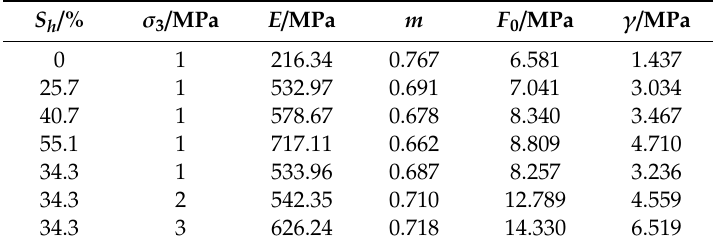
Table 1. The residual strength correction coe ffi cient δ can be determined from the experimental results using the inversion trial method. The confining pressure values σ 3 in the experiments were 1.0 MPa, 2.0 MPa, and 3.0 MPa. Table 1. Material parameters of hydrate-bearing sediments and Weibull distribution